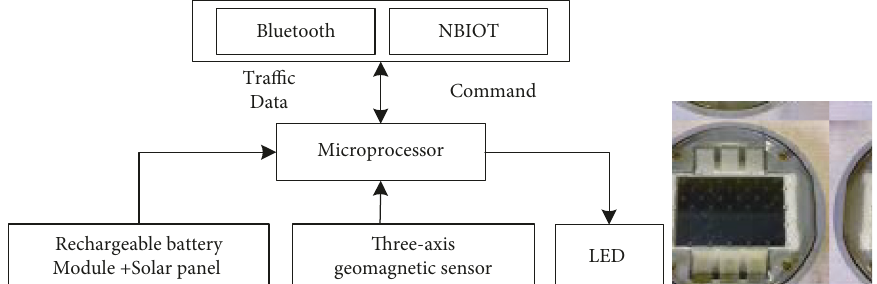
Figure 2: Physical and structural diagram of SRS.